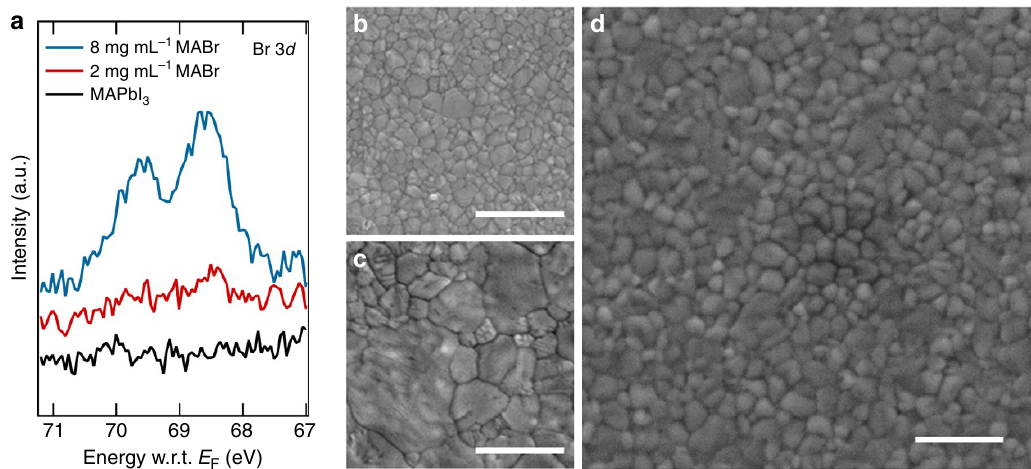
Figure 6 | Effect of MABr treatment on XPS core-level analysis and film morphology. ( a ) XPS spectra of the Br 3 d core-level region for MAPbI 3 thin films and those treated with low (2mgml (cid:2) 1 ) and high (8mgml (cid:2) 1 ) concentration MABr solutions. Top-view SEM images of ( b ) a high-quality MAPbI 3 thin film and those treated with 2mgml (cid:2) 1 ( c ) MABr and ( d ) MAI solutions. Scale bars, 1 m